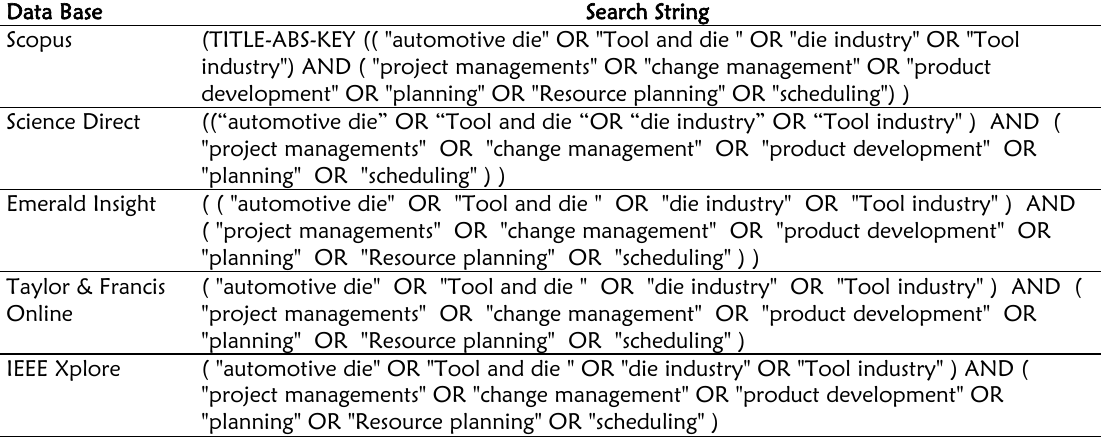
Table 9: The search string and database